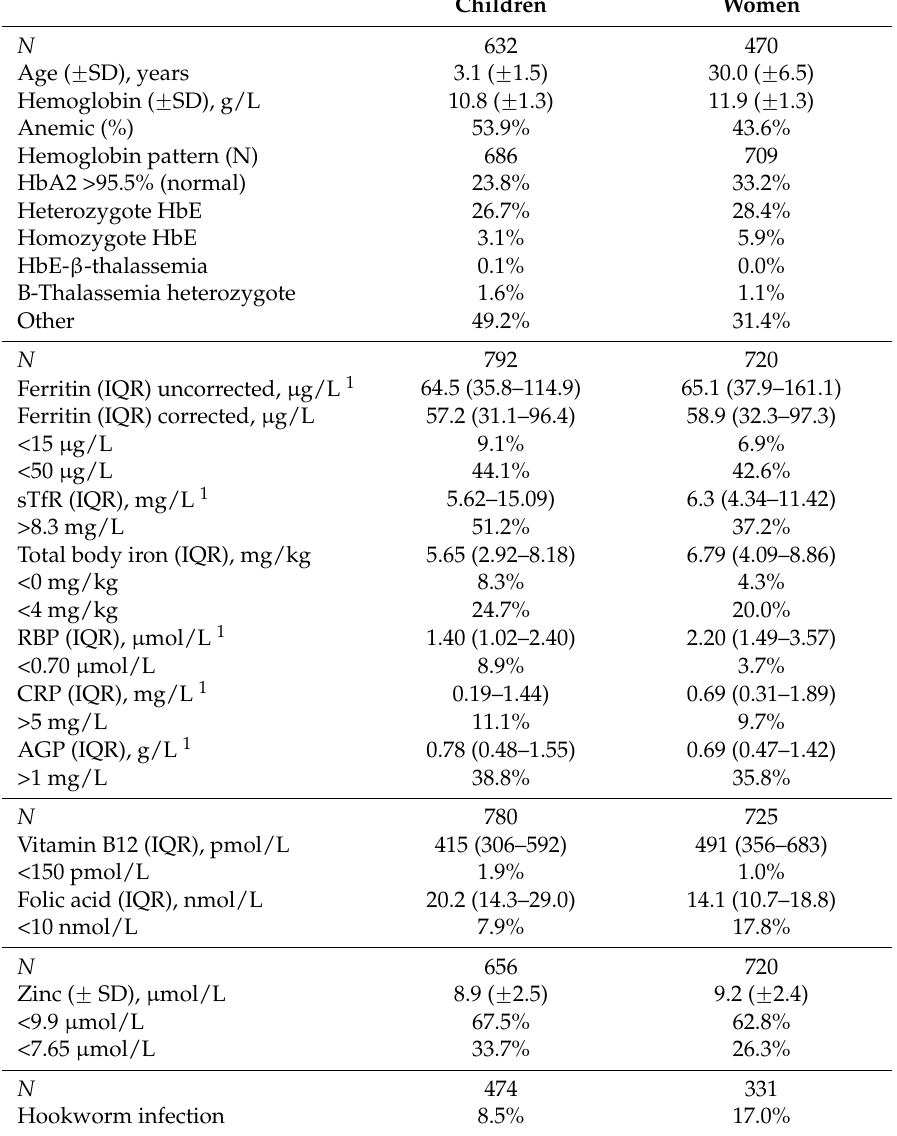
Table 2. General characteristics and micronutrient status of the study population 1